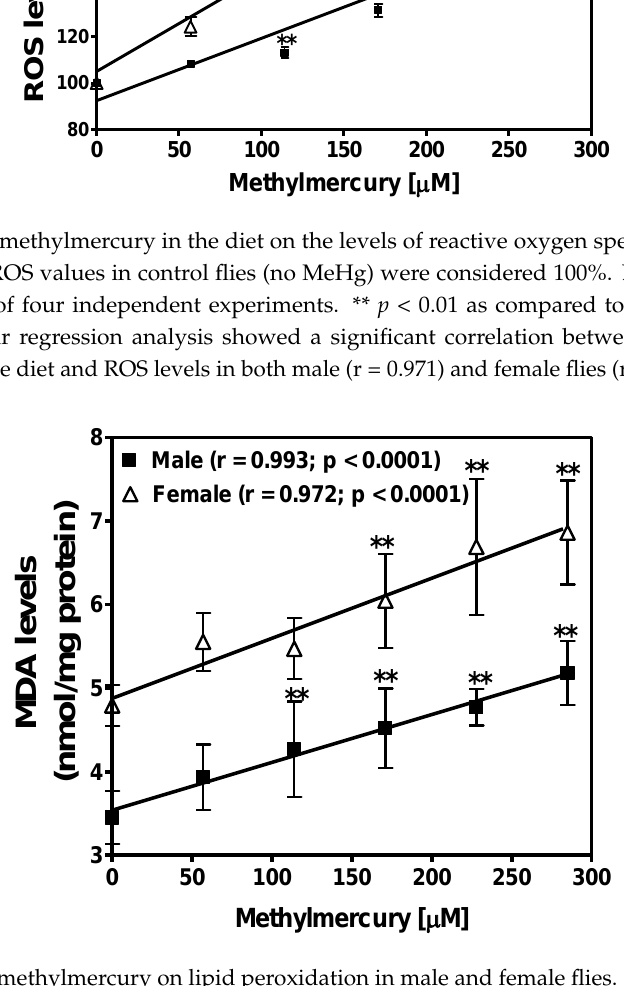
Figure 5. Effect of methylmercury on lipid peroxidation in male and female flies. Lipid peroxidation was assessed by measuring the levels of malondialdehyde (MDA), an end product of lipid peroxidation. Data are presented as Mean ± S.E.M of 4 independent experiments. ** p < 0.01, as compared to controls, ANOVA (Dunnette). Linear regression analysis showed a significant correlation between MeHg concentration in diet and MDA levels in both male (r = 0.993) and female flies (r = 0.972).